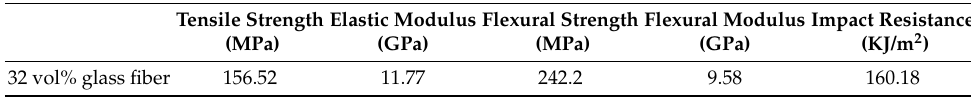
Table 3. Properties of 32 vol% glass fiber composites.